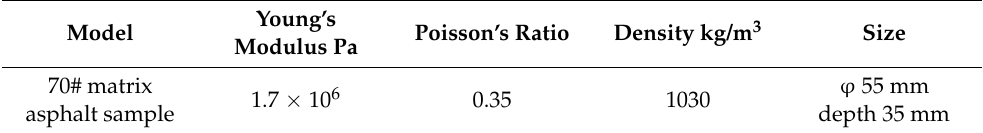
Table 3. Material parameter setting of the asphalt sample